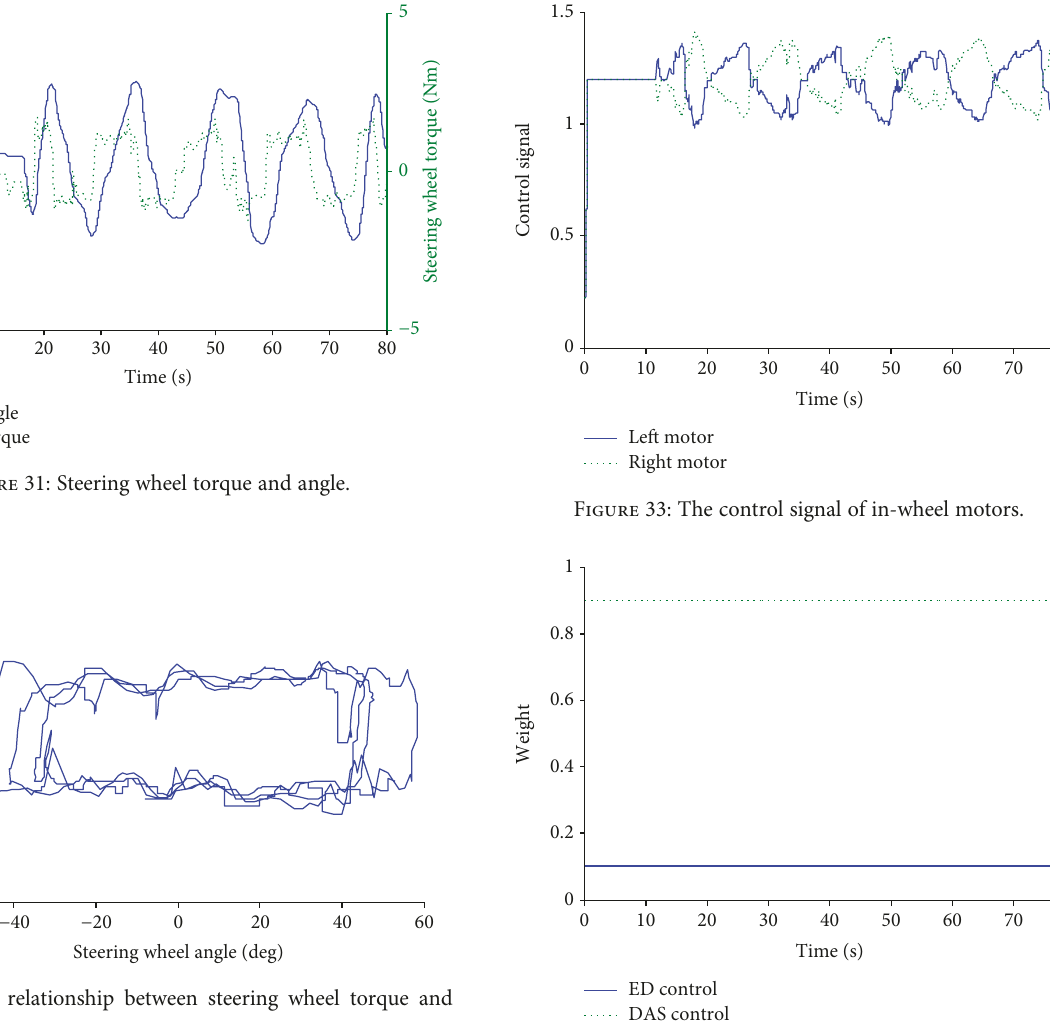
Figure 34: Weight coe ffi cient.